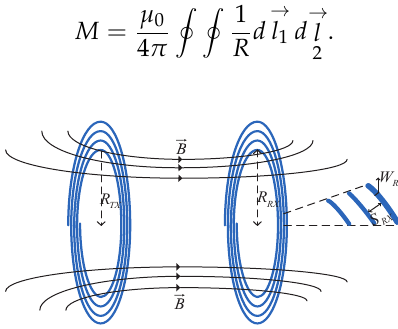
Figure 5. Energy transmission process of the WPT